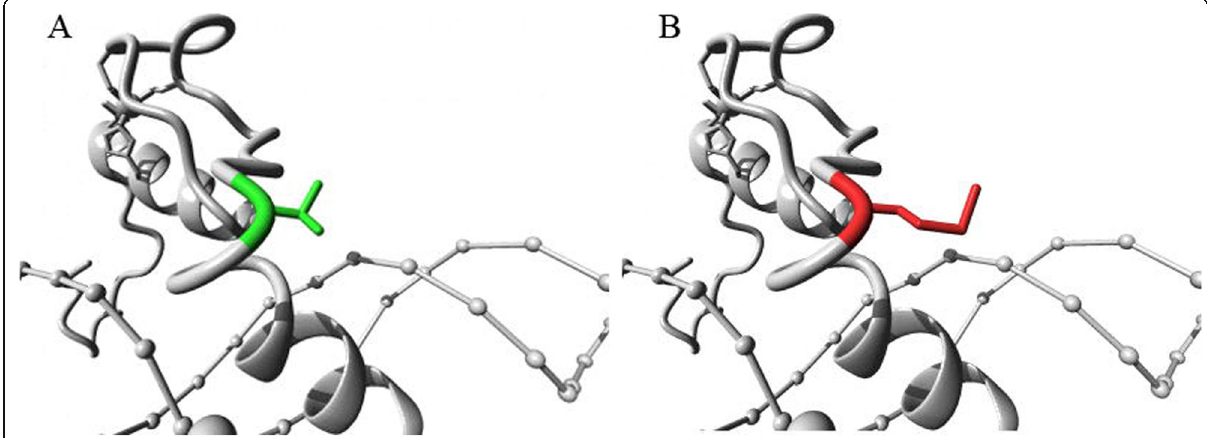
Fig. 4 Structural modelling of the predicted wild type ( a ) and mutant p. Thr541Met ( b ) proteins. The mutation is near the second zinc